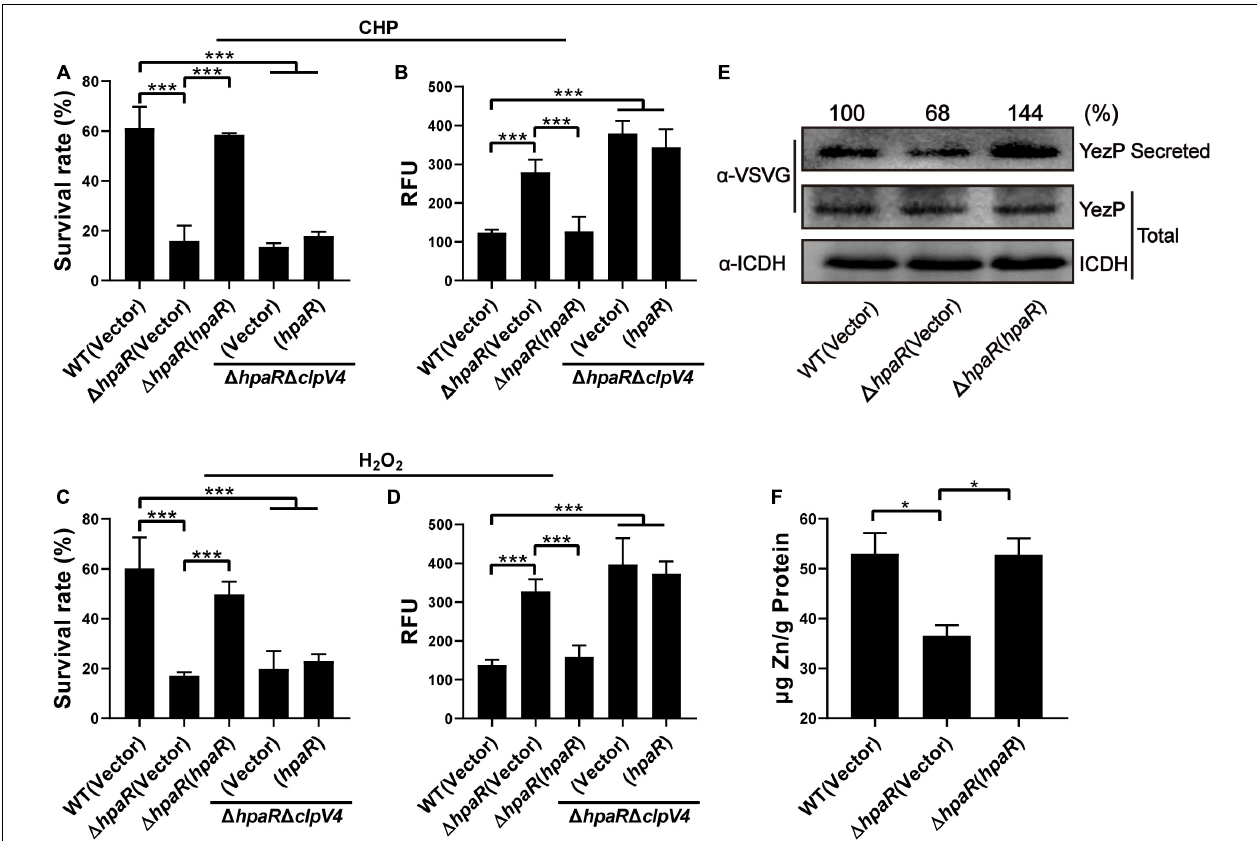
FIGURE 4 | HpaR plays a role in resisting oxidative stress via T6SS4. Survival rate of indicated Y. pseudotuberculosis strains were determined after treatment with CHP (A) or H 2 O 2 (C) for 1 h. (B,D) Intracellular ROS of indicated strains were stained with H 2 DCFDA dye (Invitrogen) and fluorescence signals were measured using a SpectraMax M2 Plate Reader (Molecular Devices) with excitation/emission wavelengths of 495/520. (E) Western blot detection of YezP secretion in Y. pseudotuberculosis wild-type, (cid:49) hpaR mutant, and its complementary strain (cid:49) hpaR ( hpaR ). Proteins in culture supernatant of relevant Y. pseudotuberculosis strains expressing YezP-VSVG were probed for VSVG (upper) by immunoblotting. (F) Mid-exponential phase of Y. pseudotuberculosis strains were exposed to 1.5 mM H 2 O 2 for 30 min in PBS containing 1 µ M ZnCl 2 . Zn 2 + associated with bacterial cells was measured by inductively coupled plasma mass spectrometry (ICP-MS). Data shown are the average of three independent experiments. The error bars indicate the standard deviation from three independent experiments. *** P < 0.001; ** P < 0.01; * P <